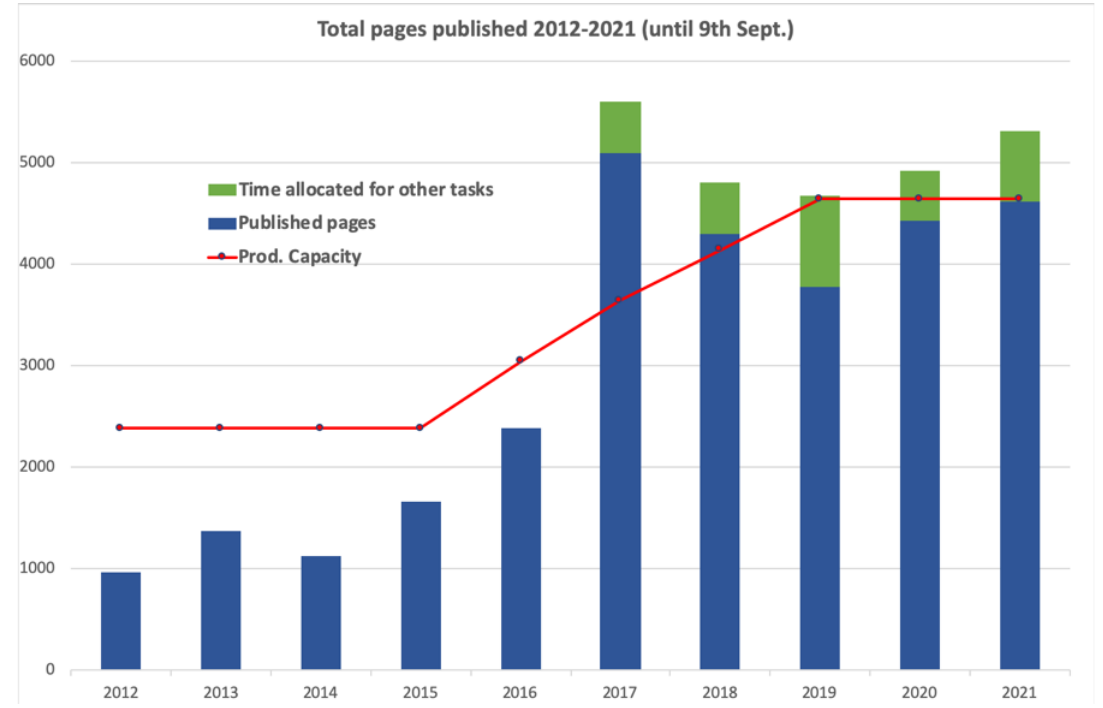
Fig. 3. Capacity production of European Journal of